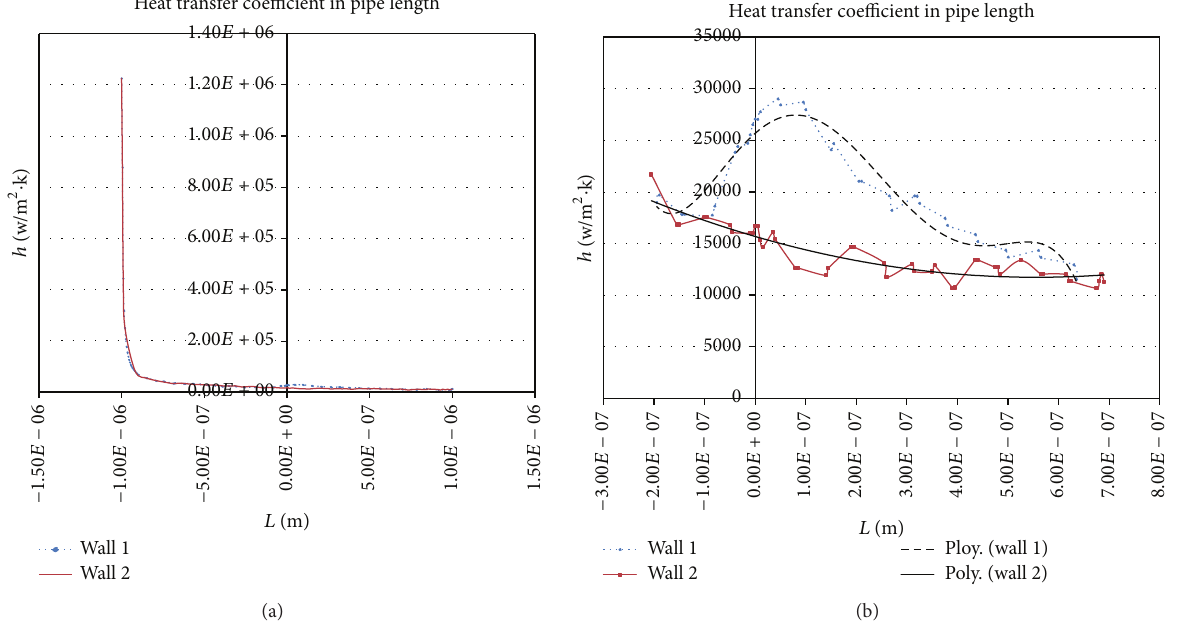
Figure 8: Case 3, convective heat transfer coefficient on walls 1 and